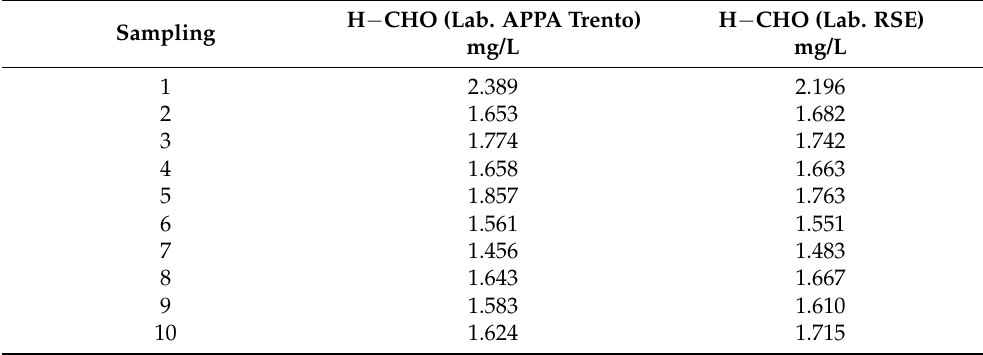
Table 12. Comparison between the analyses carried out with the VDI 3862-2 method conducted by Lab. APPA Trento on the solutions sampled by both during Second Campaign.